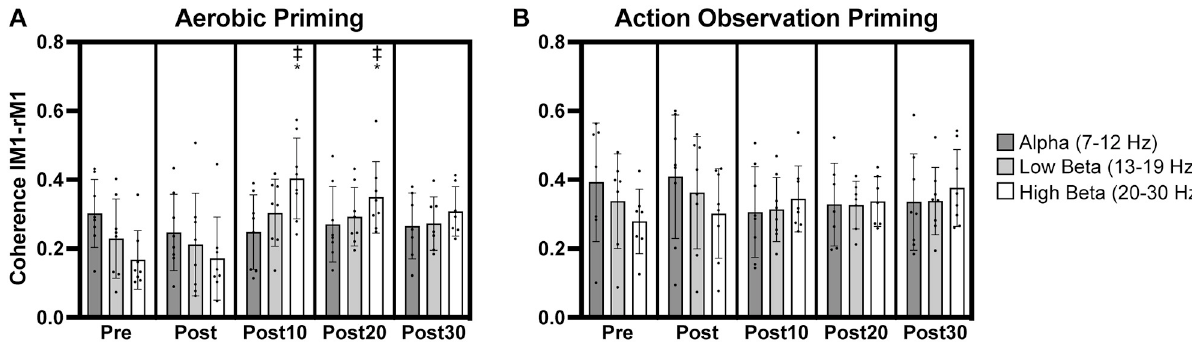
Fig 5. Coherence in leads overlying left primary motor (lM1) and right primary motor (rM1) cortices. Increases in high beta lM1-rM1 coherence occurred following aerobic priming (A). ‡ indicates significant increase from pre timepoint. * indicates significant increase from post timepoint.